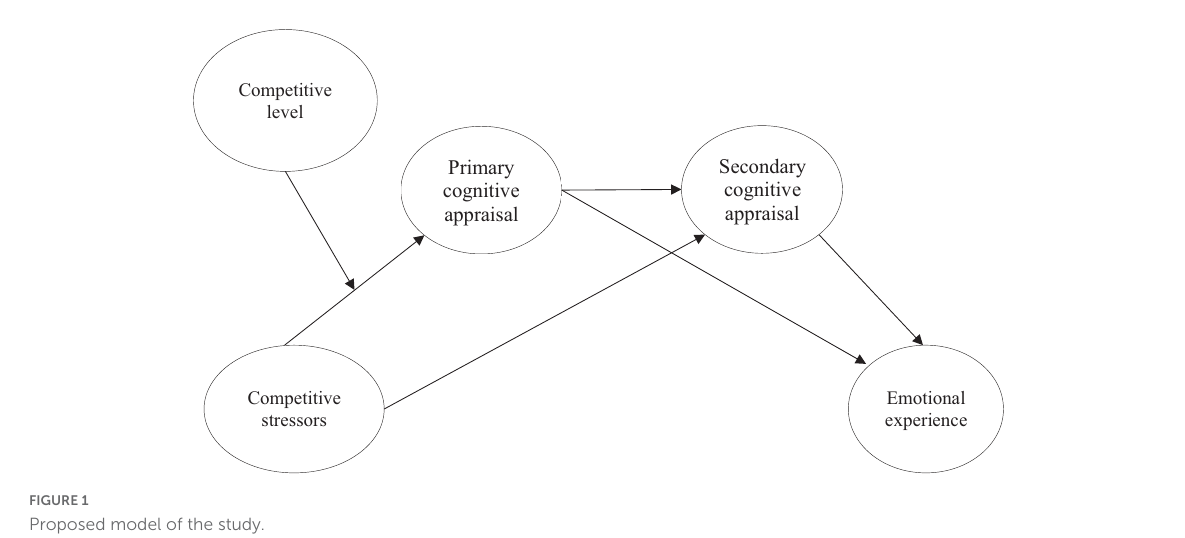
FIGURE1 Proposed model of the